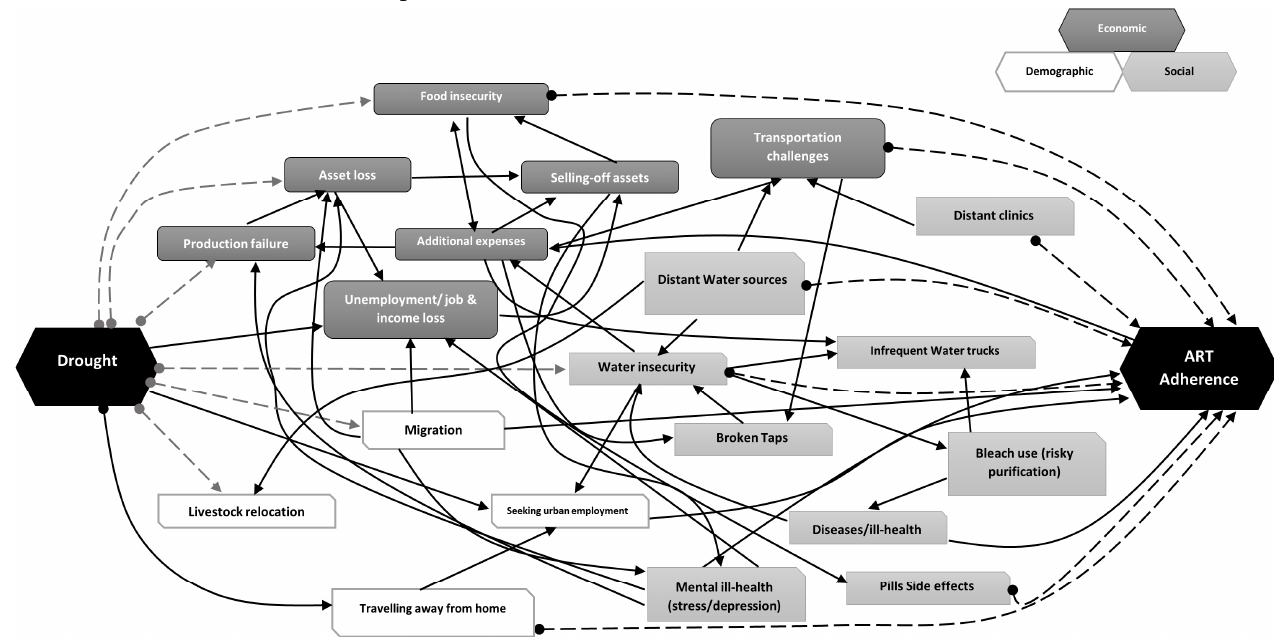
Figure 2. Systems diagram showing the interconnectivities between drought and treatment adherence as conceptualized from interviews conducted with study participants. The grey- and black-dotted arrows show factors directly caused or influenced by the drought, and those that HIV treatment adherence was sensitive to. The continuous black lines designate the interconnections between and among all the factors associated with drought and HIV ART